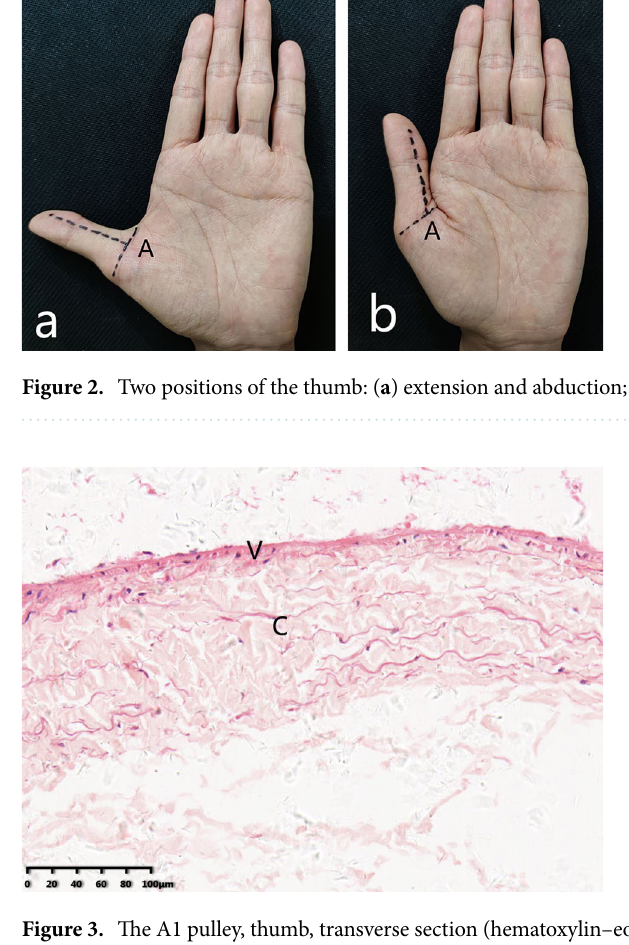
Figure 3. The A1 pulley, thumb, transverse section (hematoxylin–eosin stain). The pulley is composed of two layers: a vascular, outer, frictionless layer (V) and a collagenous layer (C) . (Original magnification×200).